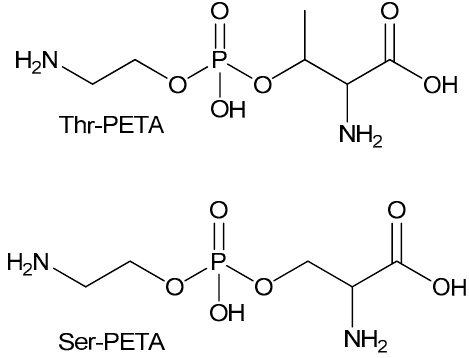
Figure 2. Representative 1 H NMR spectra of protein-free lipid-free extract from S. lucioperca gill with the metabolite assignment: ETA—ethanolamine; Gl-PhCholine—glycerophosphocholine; GSH—glutathione; i-But—isobutyrate; myo-In— myo -inositol; NAA— N- acetyl-aspartate; NAH— N- acetyl-histidine; OSH—ovothiol A; PETA—phosphoethanolamine; PhCholine—phosphocholine; scyllo-In— scyllo -inositol; Ser-PETA—serine phosphoethanolamine; Tau—taurine; Thr-PETA—threonine phosphoethanolamine. For amino acids and nucleotides, standard 3-letter symbols are used.